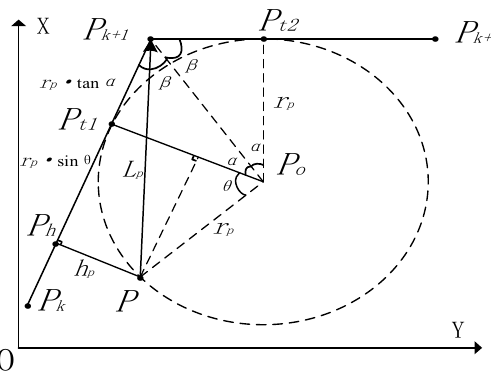
Figure 12. Steering point control.